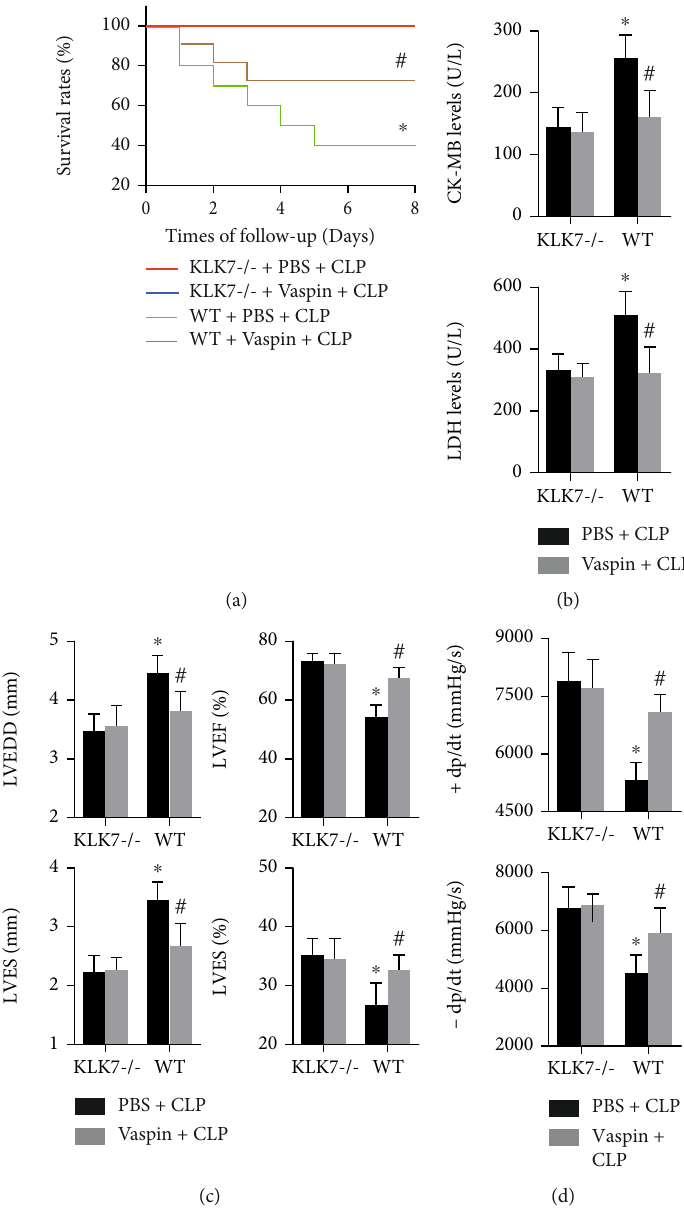
Figure 6: E ff ects of KLK7 de fi ciency on sepsis-induced cardiac injury in mice. (a) The survival rates of septic WT mice and KLK7-/- mice were measured (log-rank test). (b) CK-MB and LDH concentrations in serum were examined (two-way ANOVA). (c, d) Cardiac structure and function were measured (two-way ANOVA). N = 5 in each group. ∗ p < 0 : 05 vs. the WT + PBS + CLP group. ns p > 0 : 05 vs. the KLK7 − / − + PBS + CLP